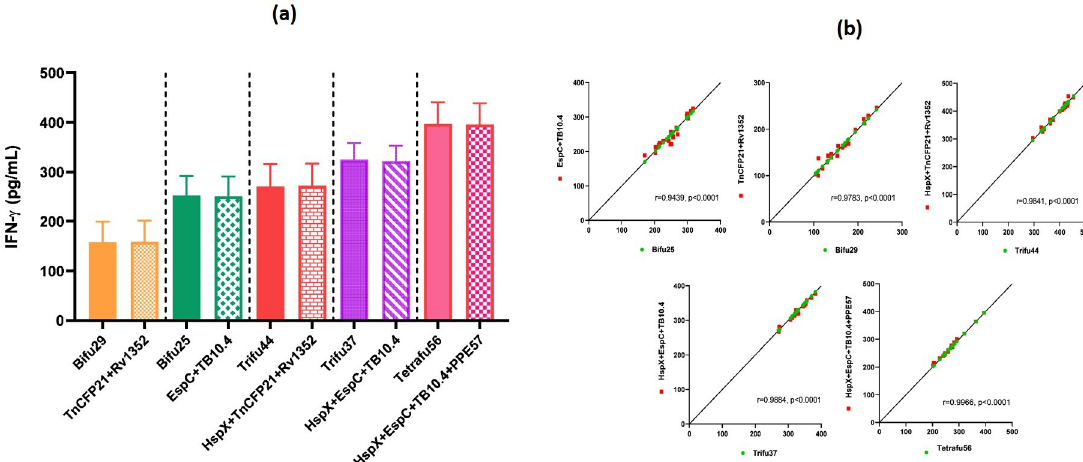
Fig 5. IFN- γ release (a) and Pearson’s correlation values (b) between IFN- γ released against mixtures of the antigens and their fusions. IFN- γ release (pg/mL) from PBMCs of active TB patients against mixtures of the antigens (red) and their fusions (green) in Pearson correlation graphs